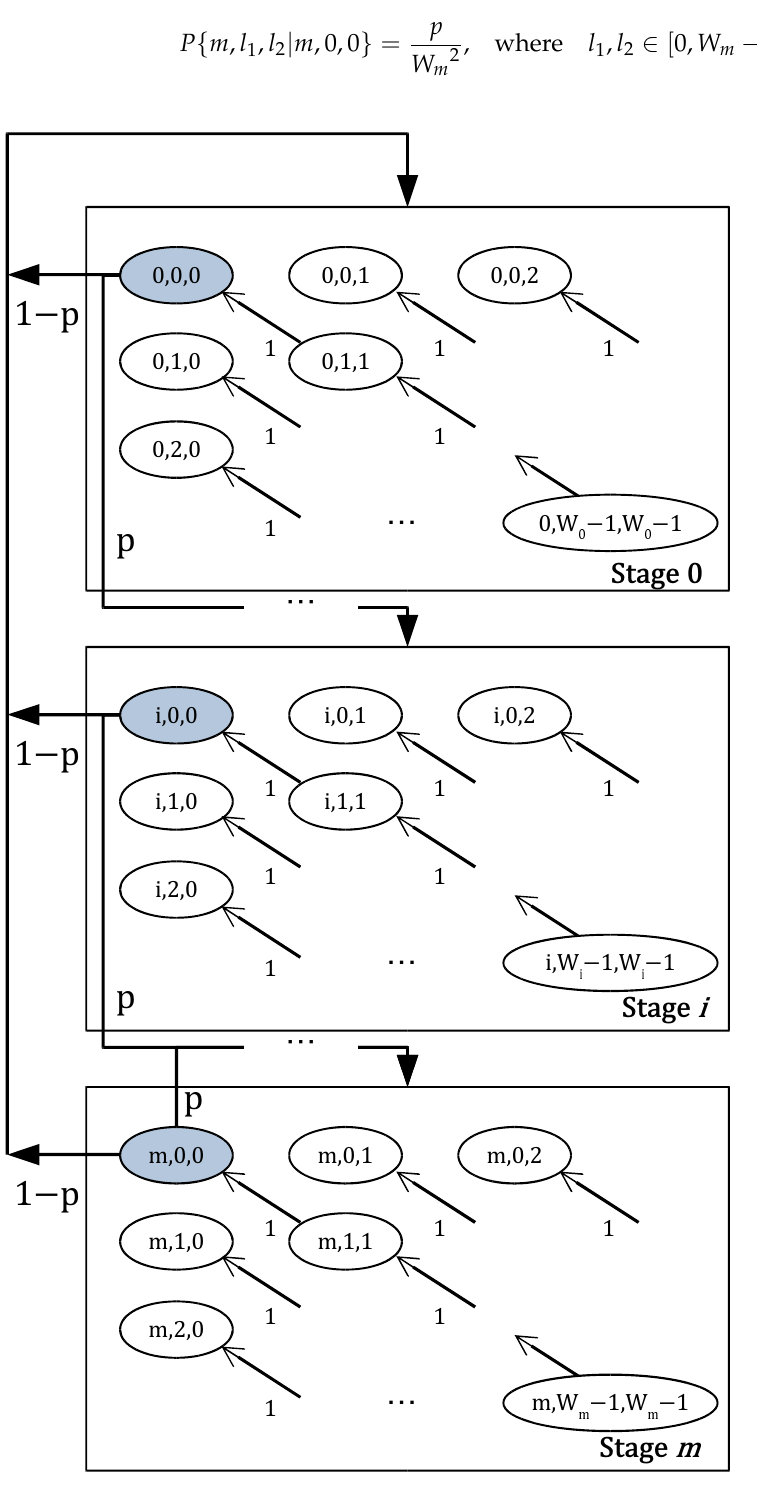
Figure 7. A 3D Markov Chain model of MLA-L when the two stations are affiliated with an MLD. In the same manner as MLA-S, we can reduce this 3D dimensional Markov Chain model to 2D Markov Chain as shown in Figure 8. In this model, the state { s , b } repre- sents the current backoff stage and the longest remaining backoff counter of an